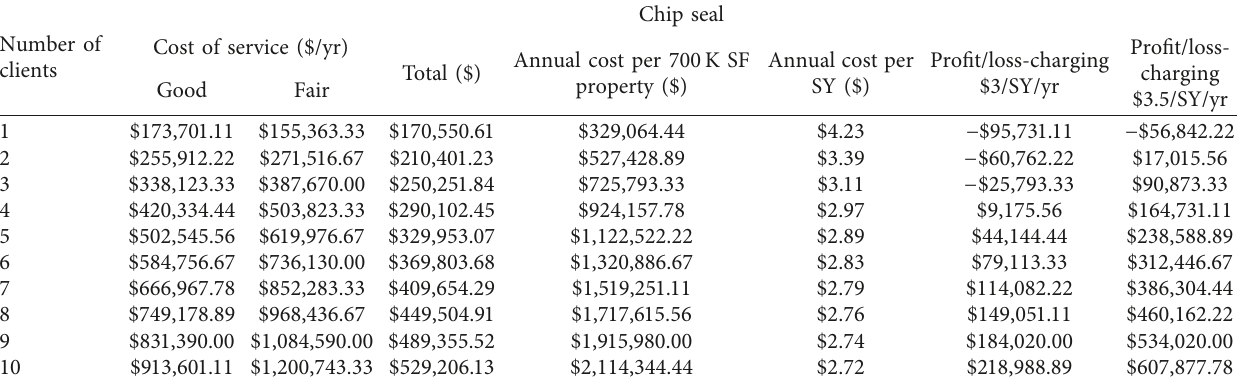
Table 6: Annual profit/loss per SY using chip seal